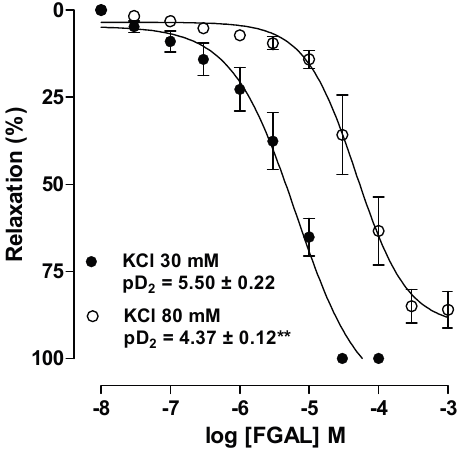
Figure 4. Effect of FGAL on tonic contractions induced by 30 mM KCl ( ● ) or 80 mM KCl ( ○ ) in rat aorta. Symbols and vertical bars represent mean ± S.E.M., respectively. Student’s t -test, ** p < 0.01 (30 mM vs. 80 mM